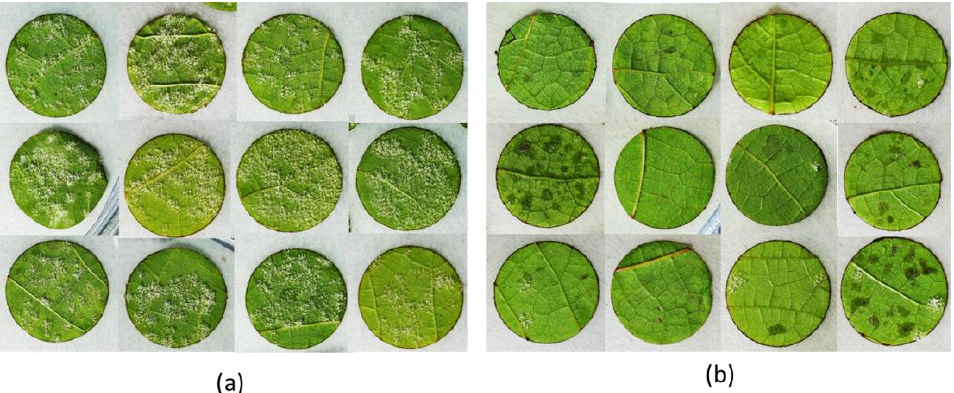
Figure 2. Different levels of sporulation 7 days after the inoculation with Plasmopara viticola on ( a ) water-treated discs (control); ( b ) Salvia officinalis phytocomplex (SOP)-treated discs.